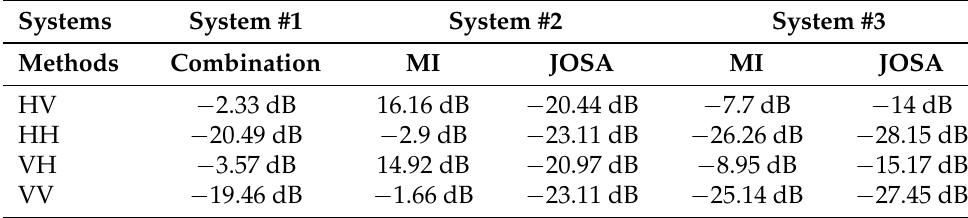
Table 3. AASR Performance (PRF = 3502